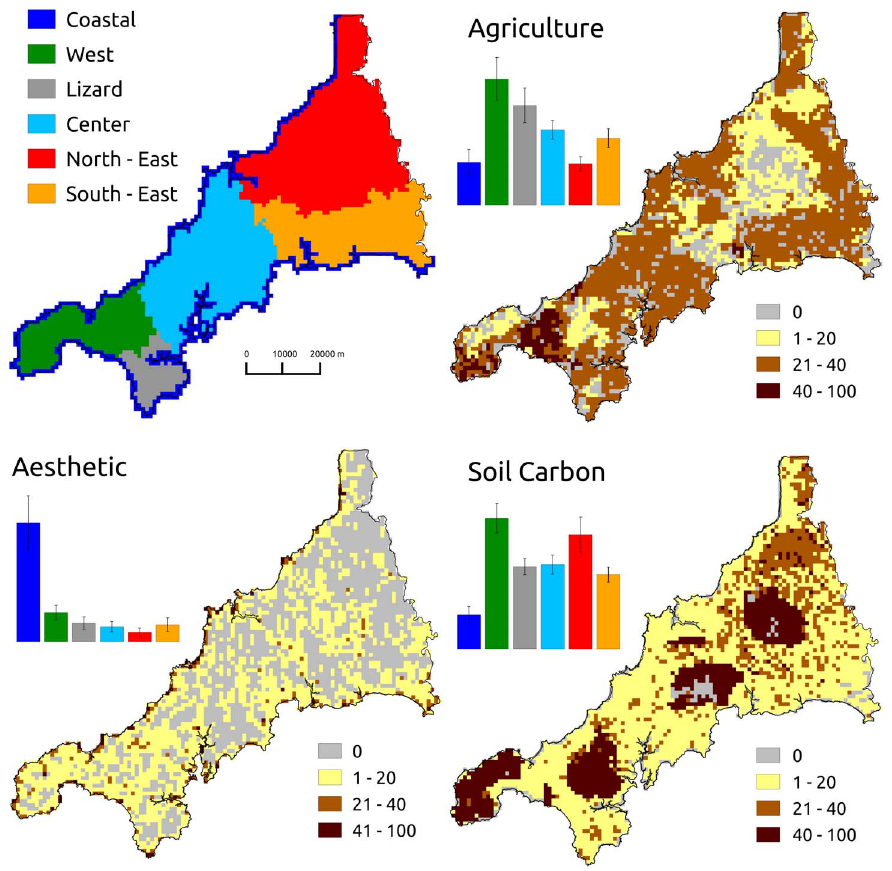
Figure 1. Study area and ecosystem services distribution. Geographical zonation of Cornwall (upper left), the distribution of agriculture, aesthetics and soil carbon (other maps; variation scaled from 0–100), and the mean value of each ecosystem service within each geographical zone (histograms).